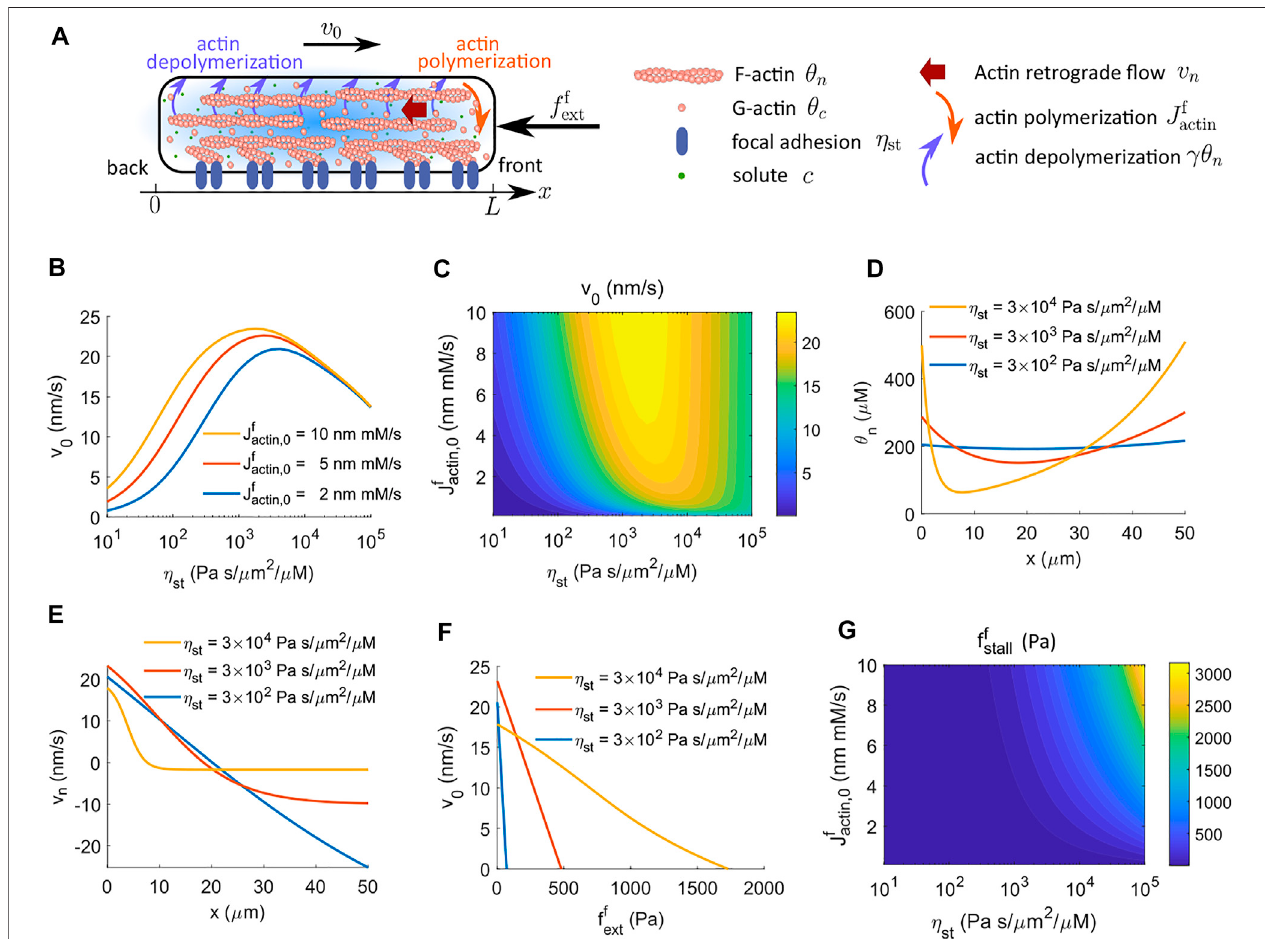
FIGURE 4 | Cell velocity and effective force generation under actin-driven cell migration when actin depolymerization happens throughout the cytoplasm. The model includes G-actin. (A) Schematics of actin-driven cell migration where actin polymerization happens at the front end of the cell while depolymerization occurs throughouttheentirecell. (B) Model prediction ofthevelocityofcellmigrationasafunctionofthestrengthoffocaladhesion, η st ,fordifferentratesofactinpolymerization at the front end of the cell. The cell velocity is biphasic in η st . (C) The contour of the predicted cell velocity, v 0 , as afunction of the coef fi cient of actin polymerization, J f actin , 0 , and the strength of focal adhesion, η st . (D) The spatial distribution of F-actin concentration for different strengths of focal adhesion, η st . (E) The spatial pro fi le of actin retrograde fl ow, v n , for different strengths of focal adhesion, η st . (F) Predicted actin-driven cell velocity as a function of the external force per unit area, f f ext , for differentstrengthsoffocaladhesion, η st . (G) Thecontourofthestallforceperunitareaforcellmigrationasafunctionofthecoef fi cientofactinpolymerization, J f actin , 0 ,and the strength of focal adhesion, η st .